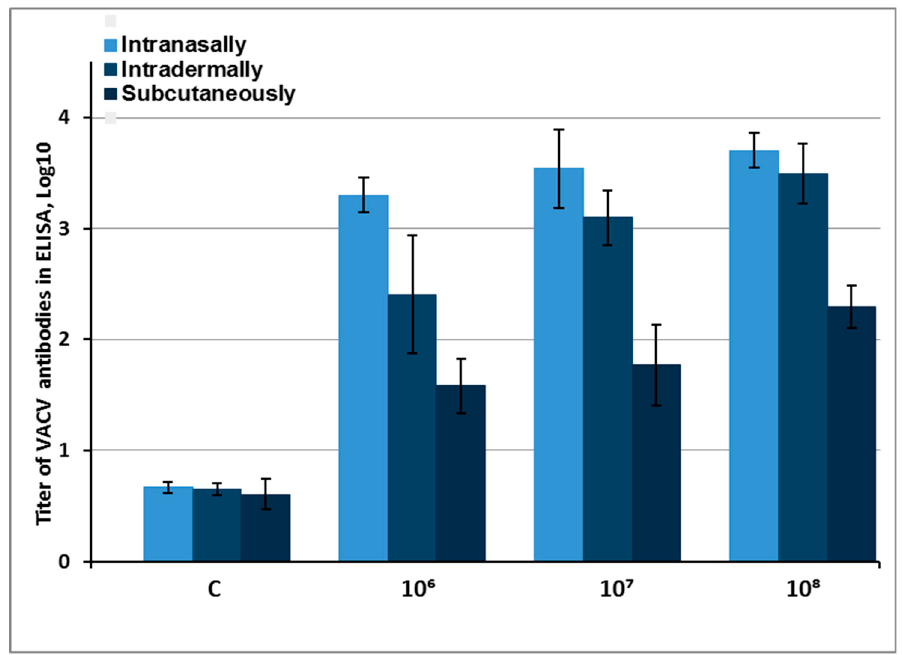
Figure 4. Concentrations of VACV-specific IgG antibodies determined by ELISA in serum samples of mice infected with different doses (10 6 , 10 7 , and 10 8 pfu) of the LIVP-14 strain via different routes. C (control)—serum samples from mice that received saline solution. The error bars indicate 95% lower and upper limits of the estimated titer. Each group consisted of six animals.